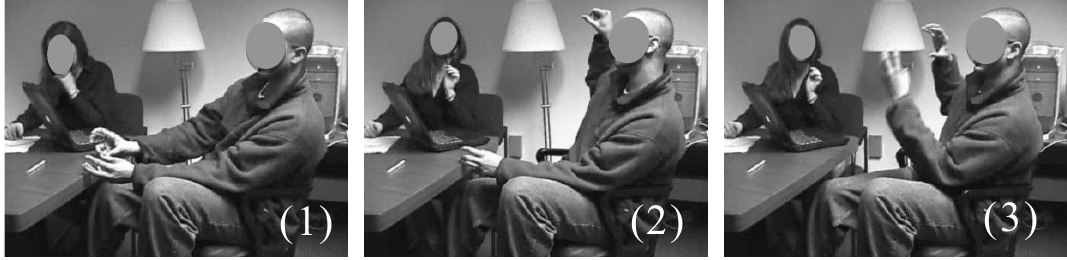
Figure 4. An example of a single-handed stroke and a simultaneous hold and the accompanying speech. In this transcription, the bold face in the speech (in quotation marks) indicates where the stroke of the gesture occurred. A dotted line indicates the hold phase by his left hand (for tomato man), a single underline indicates the hold phase by his right hand (for triangle man), and a double underline indicated the hold phase by both of his hands (for both protagonists). The numbers in the transcrip- tion correspond to the numbers given to the pictures in Figure